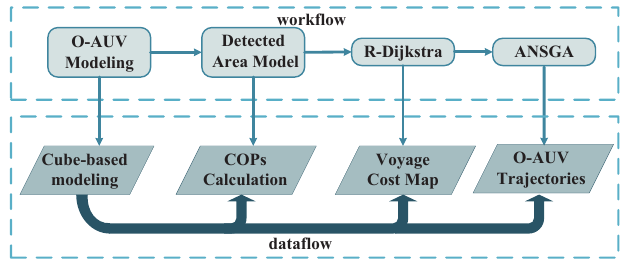
Figure 4. Workflow and dataflow of the proposed approach.